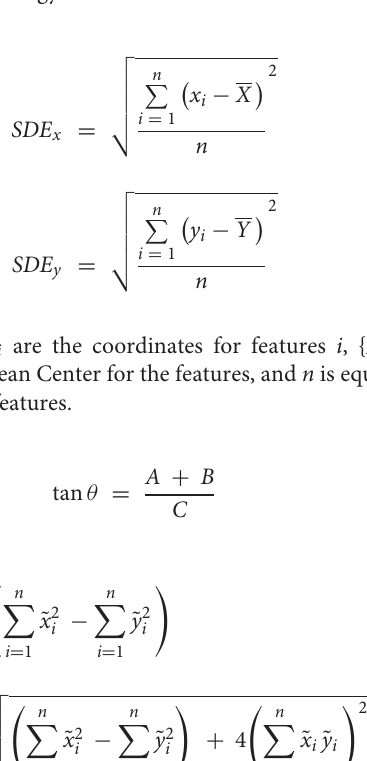
2012; Tullis-Joyce and Sen Roy, 2021). It is calculated using